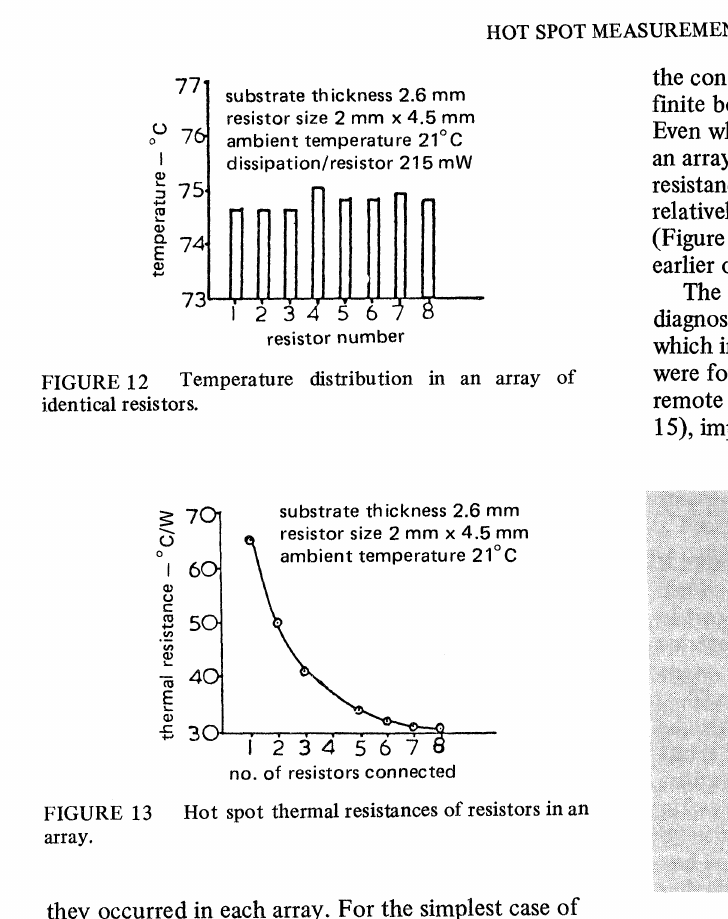
FIGURE 15 Hot spot in damaged resistor.